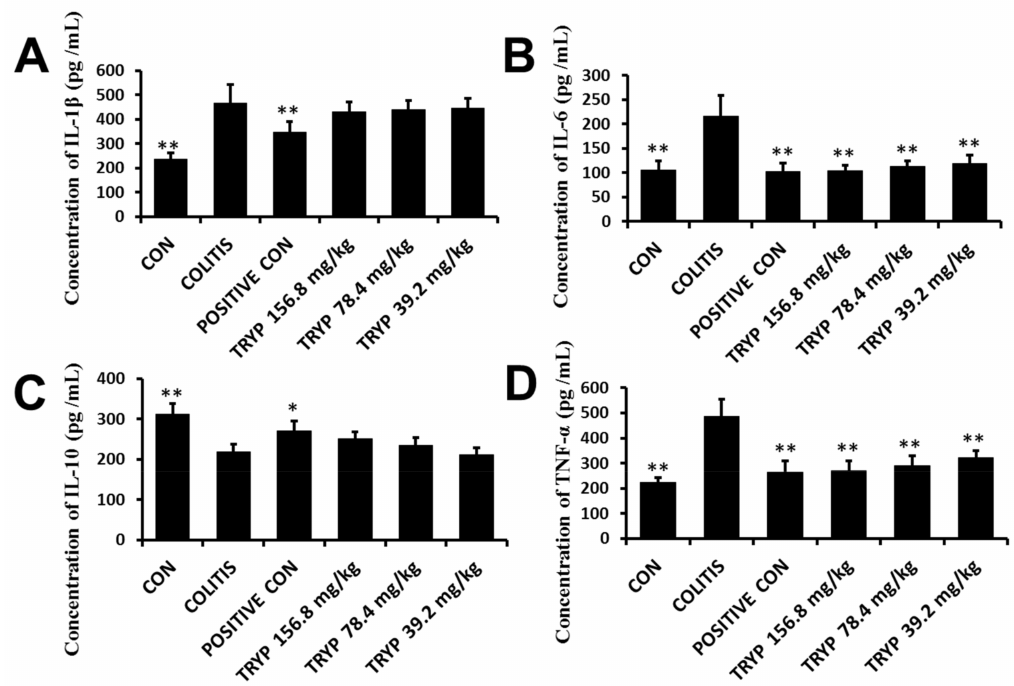
Figure 3. Levels of pro-inflammatory cytokines IL-1 β , IL-6 and TNF- α and anti-inflammatory cytokines IL-10 in each group. ( A ) The concentration of IL-1 β in each group; ( B ) The concentration of IL-6 in each group. After treatment with sulfasalazine and three concentration of TRYP, the levels of IL-6 decreased sharply; ( C ) The concentration of anti-inflammatory cytokines IL-10 in each group; ( D ) The concentration of TNF- α in each group. After treatment with sulfasalazine and three concentration of TRYP, the levels of TNF- α decreased sharply. Error bars represent means ± SEM of n = 6, * p < 0.05 and ** p < 0.01 compared with